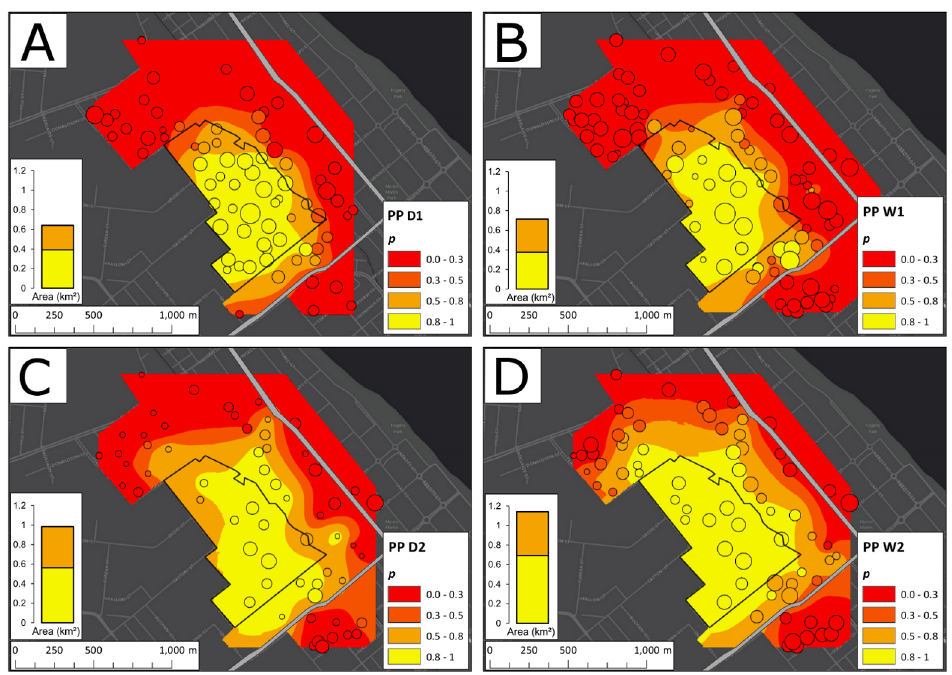
Fig 4. Ordinary Kriging of infection frequency ( p ) among traps at Parramatta Park (PP). Krigingwas performed as in Fig 3 for the first dry season (D1) (A), the first wet season (W1) (B), the second dry season (D2) (C), and the second wet season (W2). The central black polygondepicts the release zone. Trap locations are plotted as circles atop each Kriging map and are sized by a logarithmicfunction of the trap yield from each season. To the left of each Kriging plot, a stacked column chart displaysthe areas enclosedby the p > 0.8 and p > 0.5 contours, showinga constant increasein the invadedarea over time.